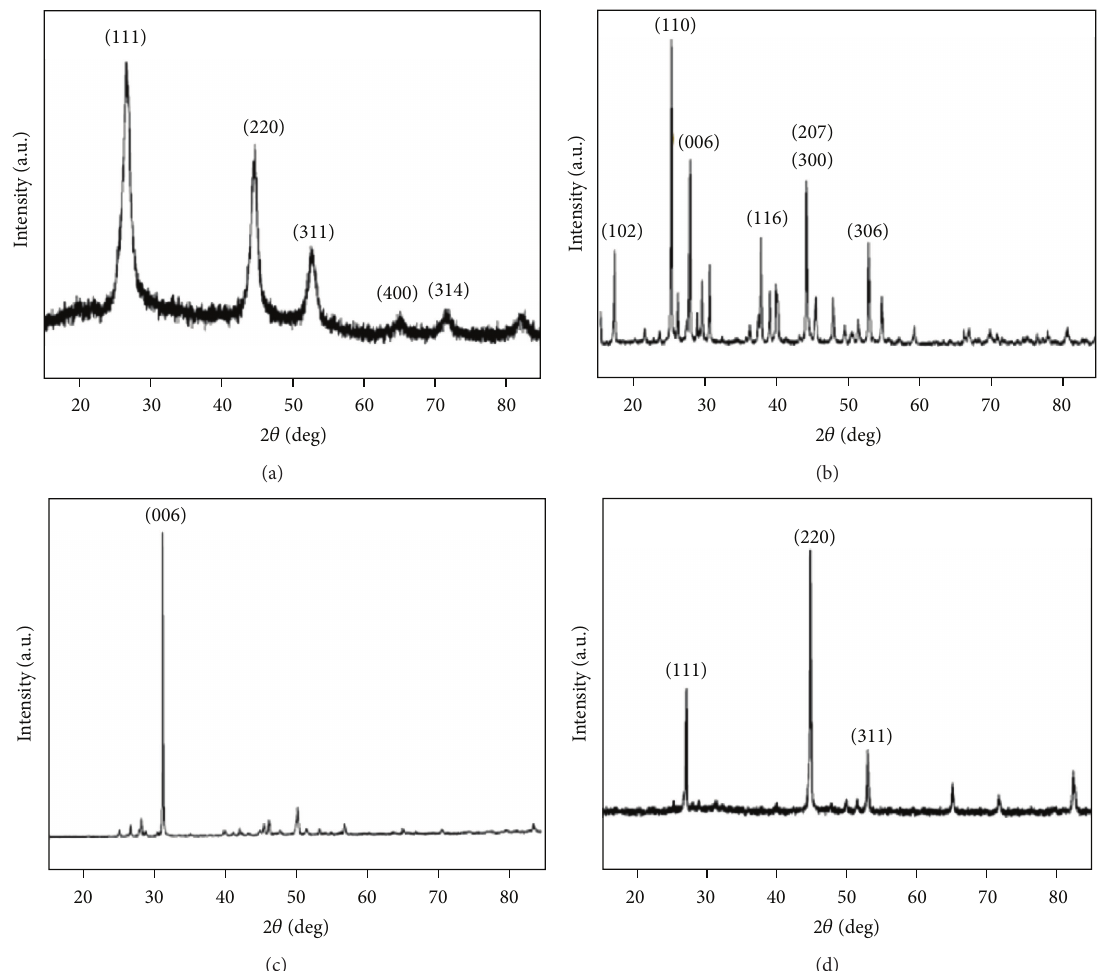
Figure 1: XRD patterns of as-prepared (a) InSe [13], (b) In 2 Se 3 [14], (c) CuSe [14], and (d) Cu 2 Se [14] particles.